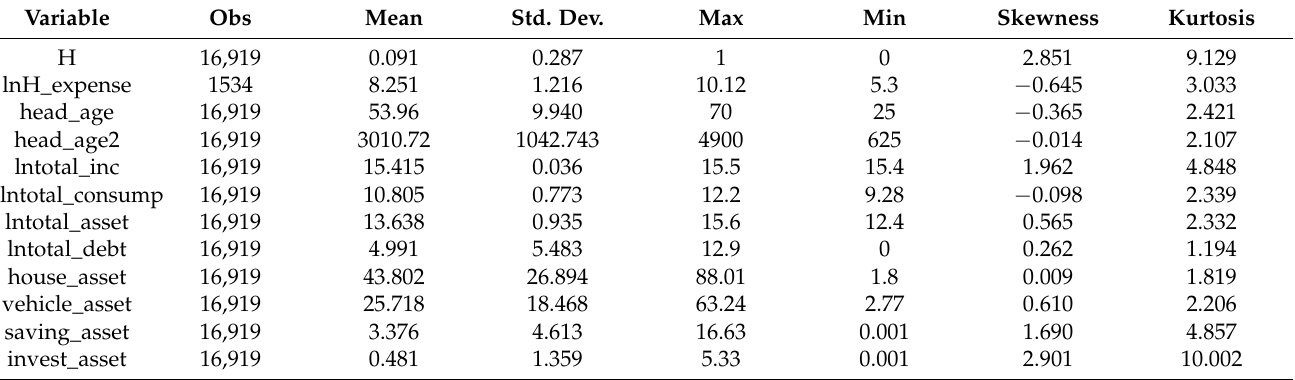
Table 3. Descriptive statistics of the main